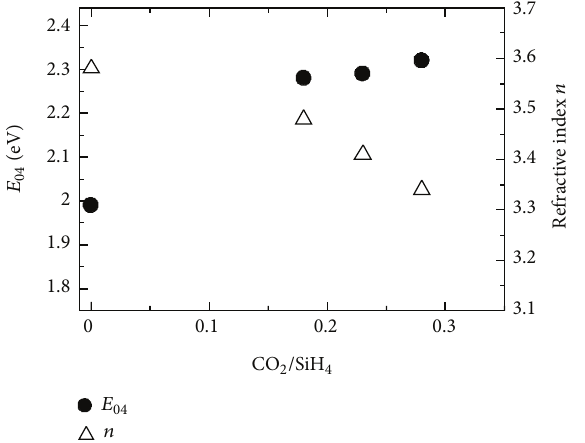
Figure 2: Optical bandgap ( 𝐸 04 ) and refractive index ( 𝑛 ) of n 𝜇 c- SiO:H films as a function of CO 2 /SiH 2 ratio.